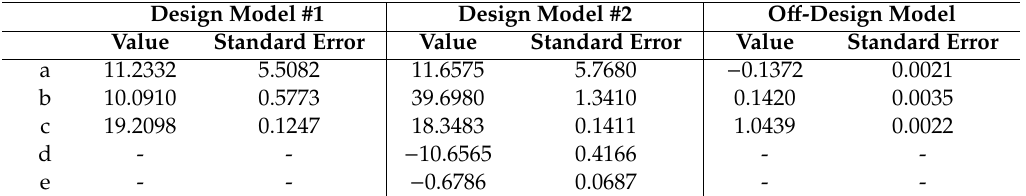
Table 4. Regression coe ffi cients and standard errors of the proposed regression models.